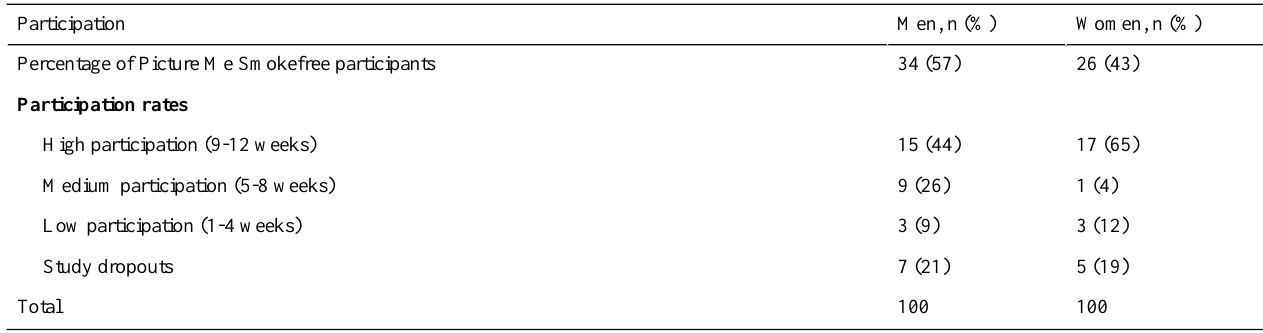
Table 2. Study participation of men (n=34) and women